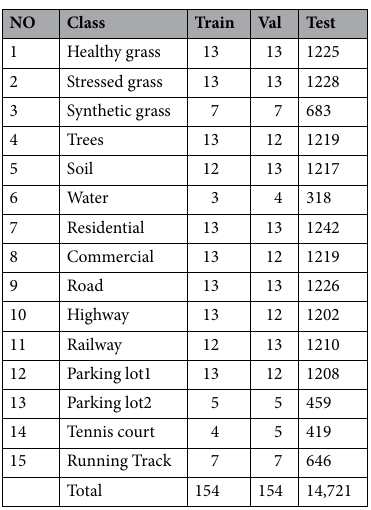
Table 4. Number of training, validation, and test samples for the HU dataset.